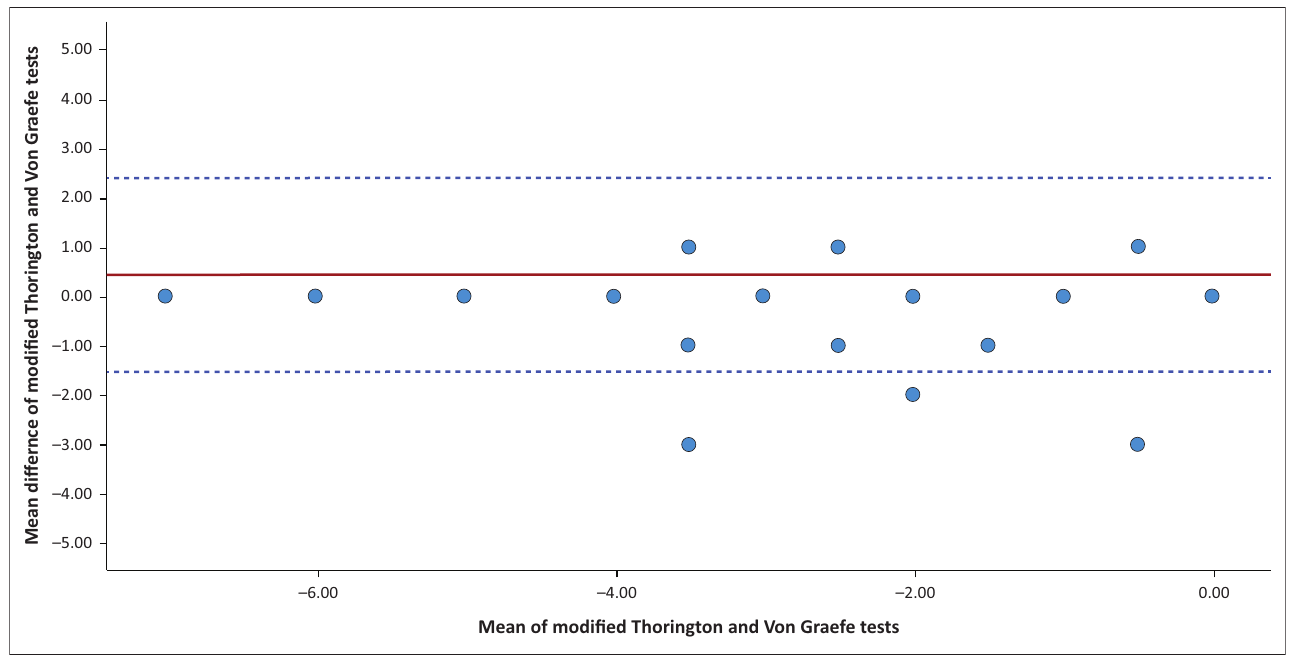
FIGURE 3: Bland–Altman plot of means versus difference of modified Thorington test and Von Graefe test measurements. The solid horizontal red line indicates the mean difference (= 0.43 Δ ) and the limits of agreement are represented by the upper and lower dotted